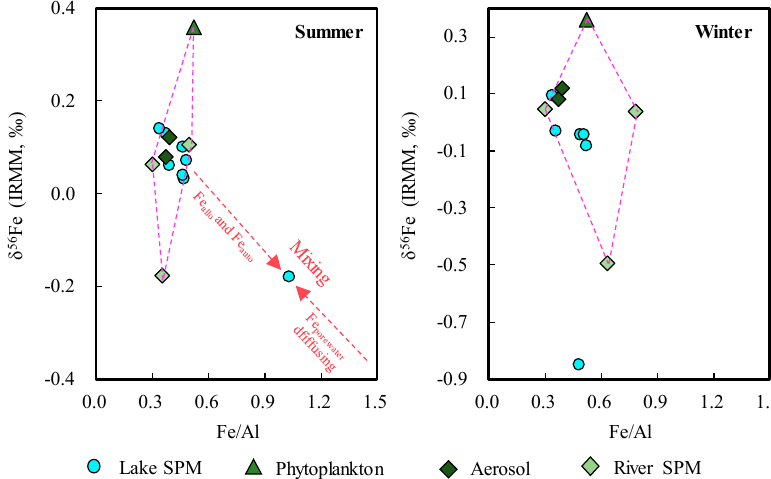
Figure 5. Source analysis of the iron isotope composition of SPM in Hongfeng